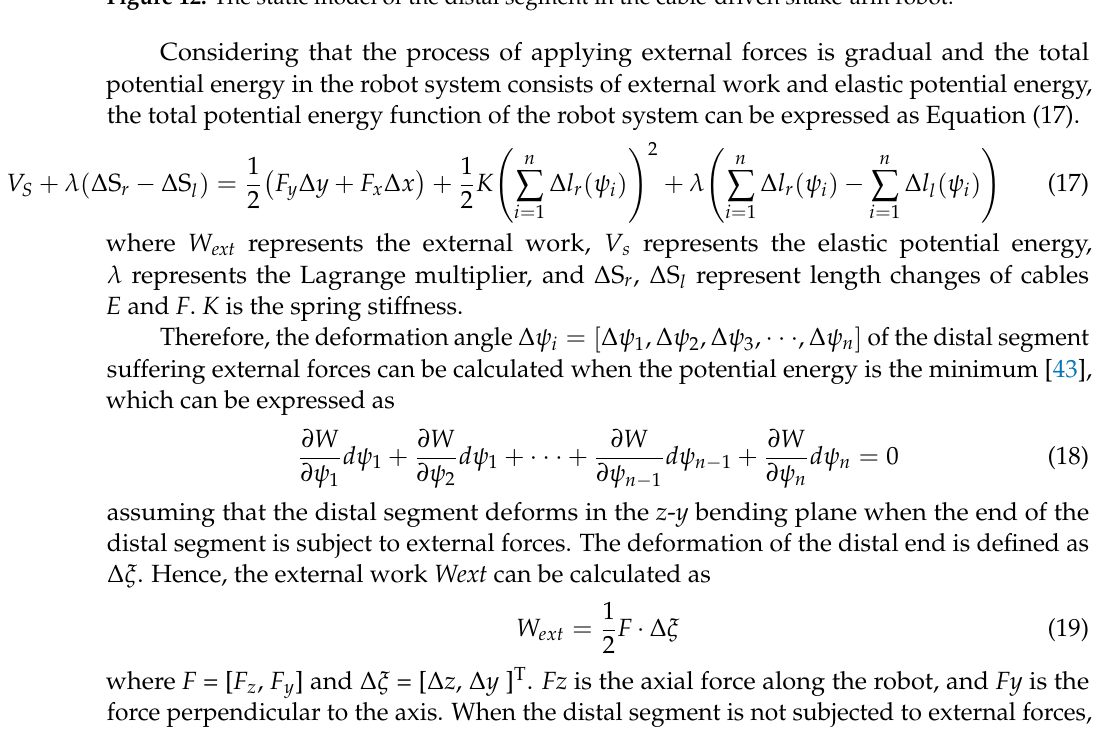
Figure 12. The static model of the distal segment in the cable-driven snake-arm